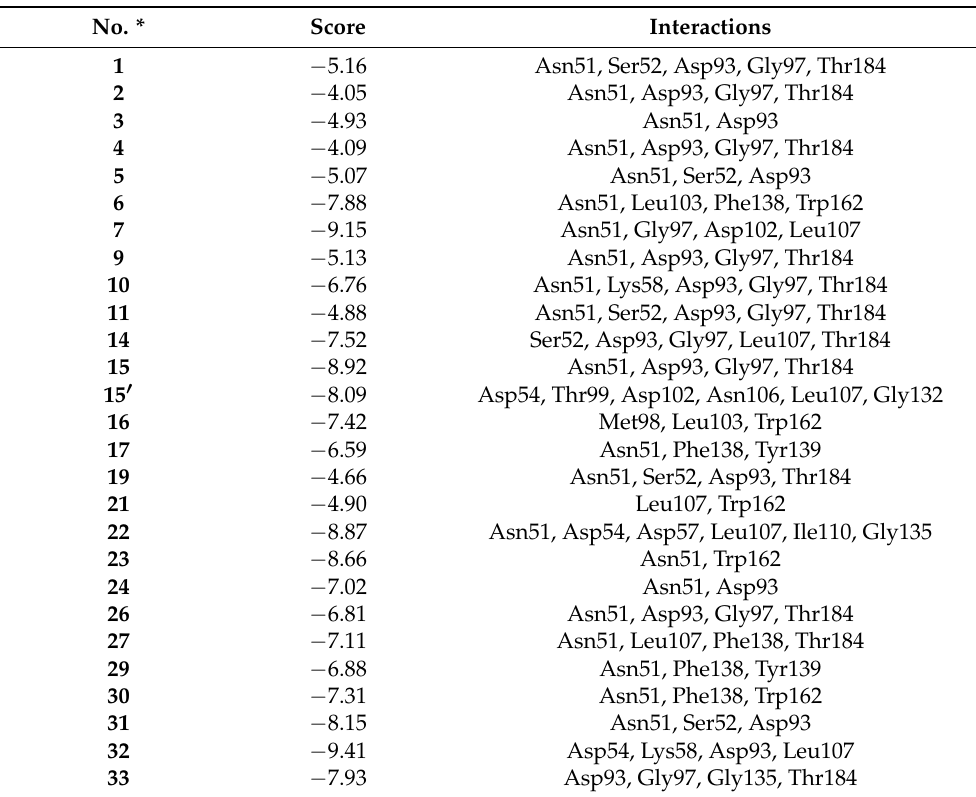
Table 3. Docking score (kcal/mol) and interactions of E. divinorum metabolites in the active site of heat shock protein 90